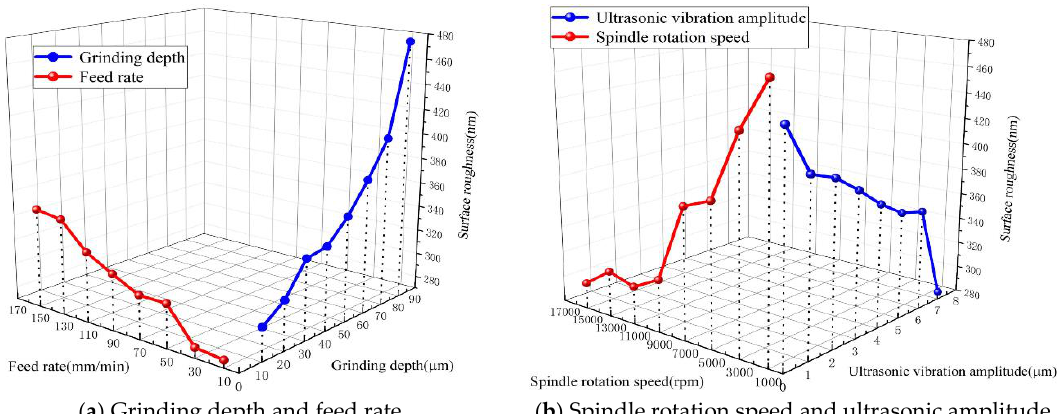
Figure 10. Influence of grinding and ultrasonic vibration parameters on the surface roughness in 3D space.